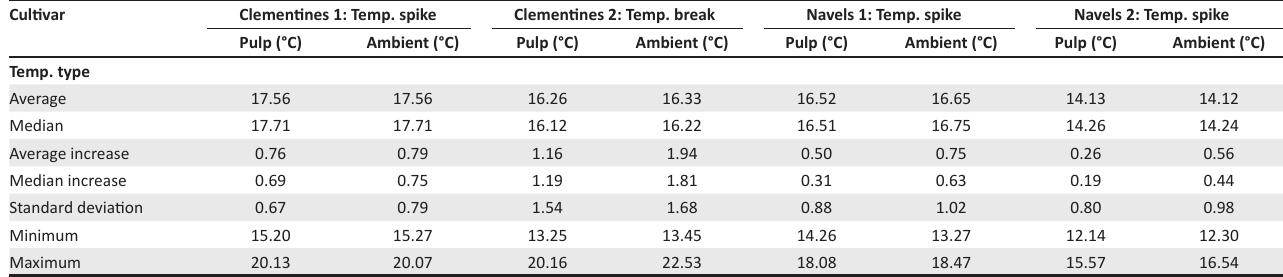
TABLE 2: Temperature dispersion of consignments: Packhouse and transportation. Cultivar Temp.